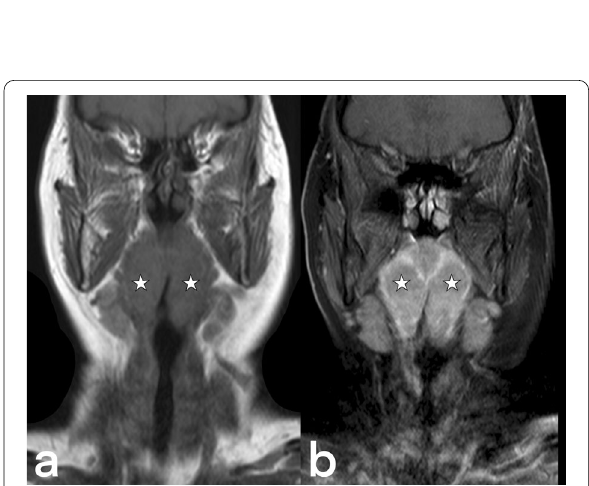
Fig. 12 A 50-year-old female. Coronal pre-contrast ( a ) and post-contrast ( b ) T1 weighted images reveal enlarged palatine